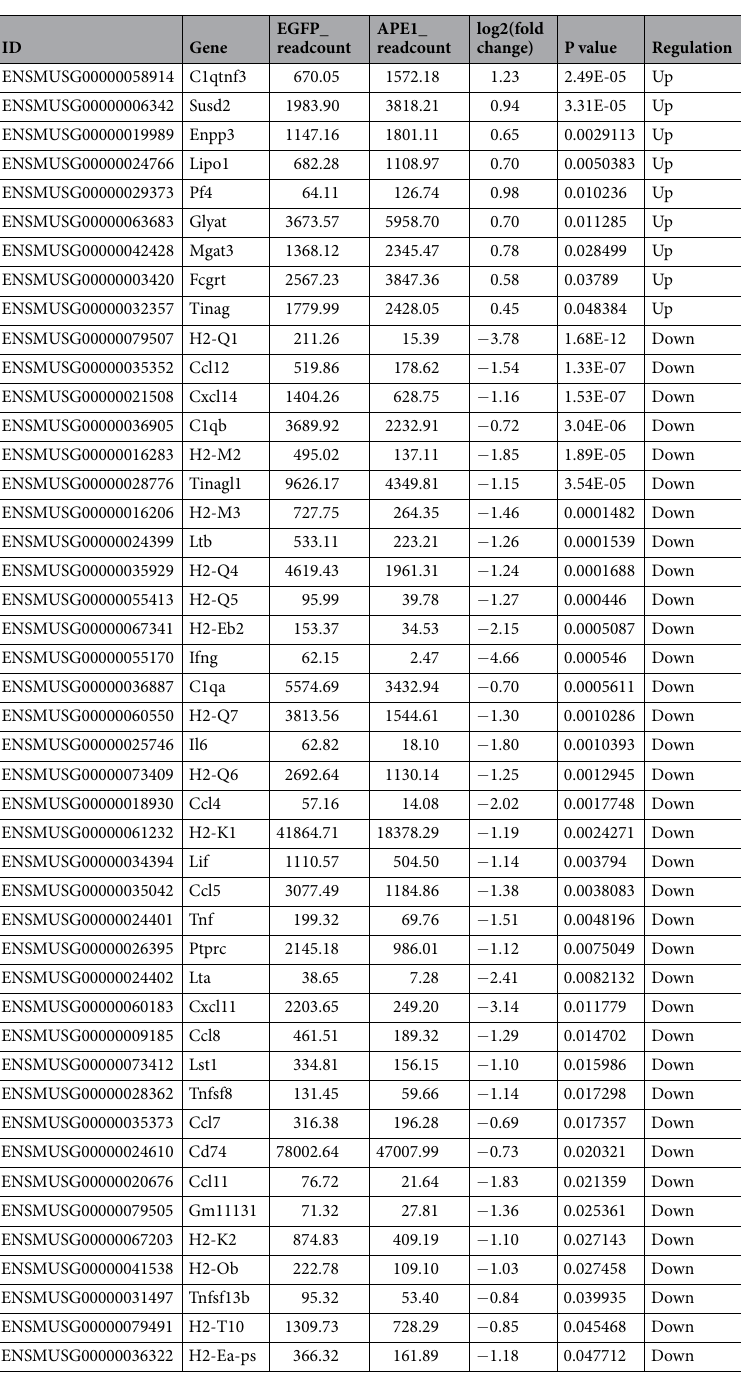
Table 1. Significant differentially expression genes of immune response between pCAG-EGFP (control) and pCAG-APE1 injected kidneys after